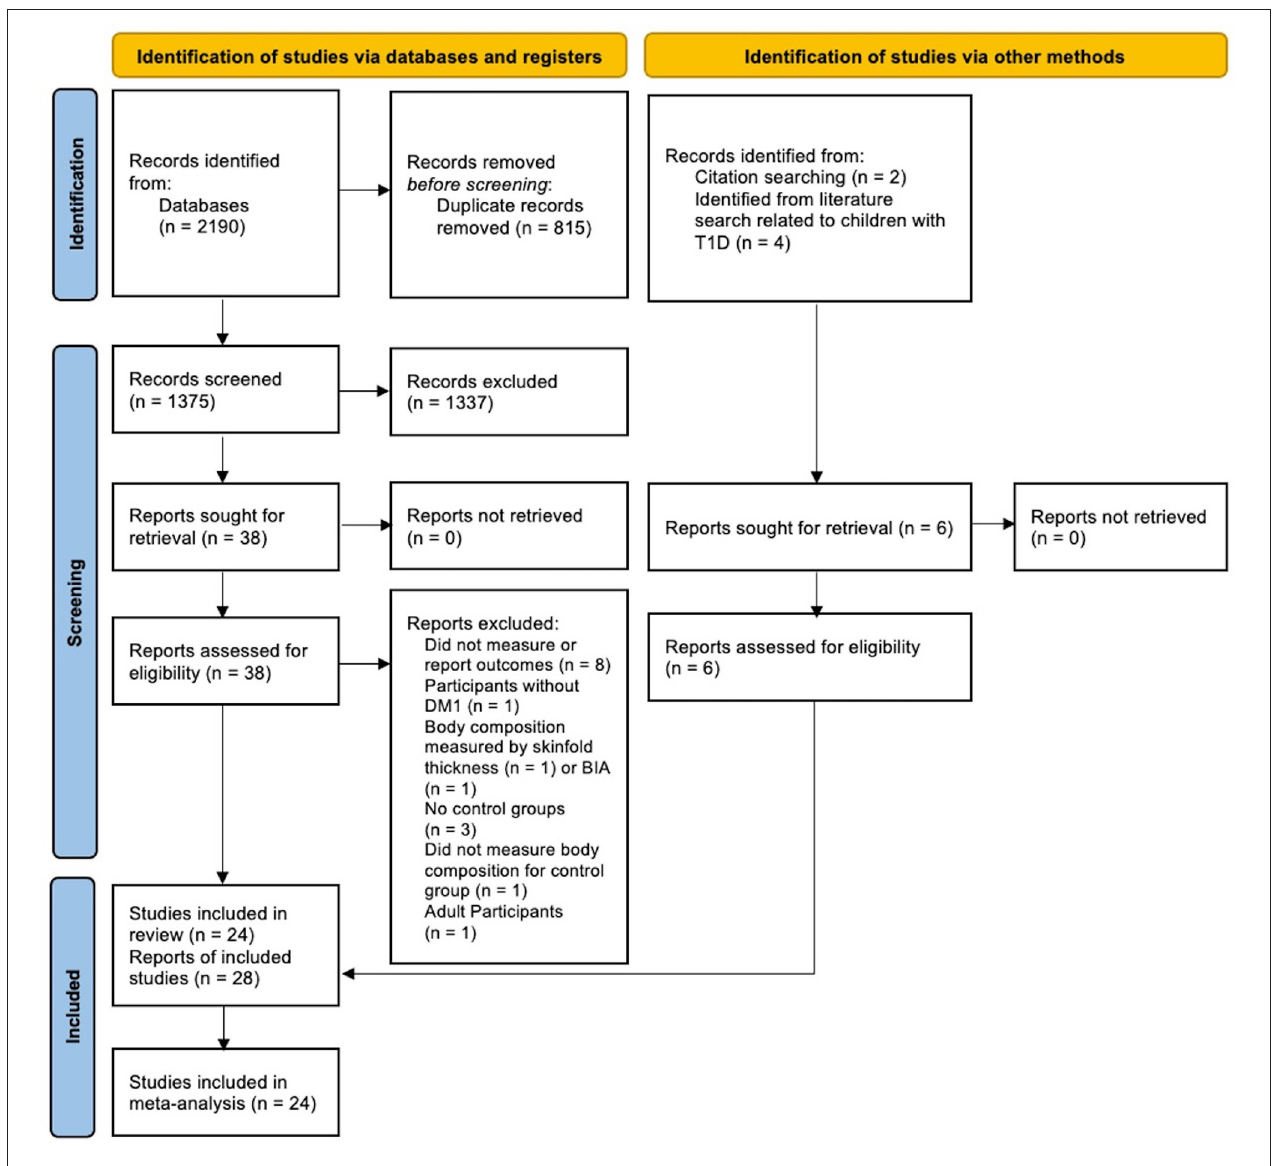
FIGURE 1 | PRISMA 2020 flow diagram illustrating search and screening results.